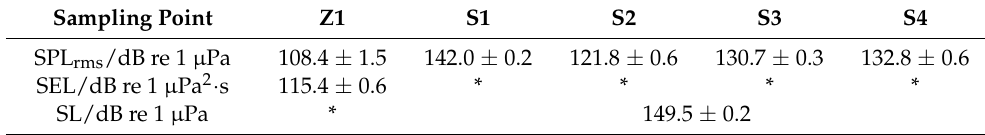
Table 1. Broadband noise at each sampling point and estimated source levels.